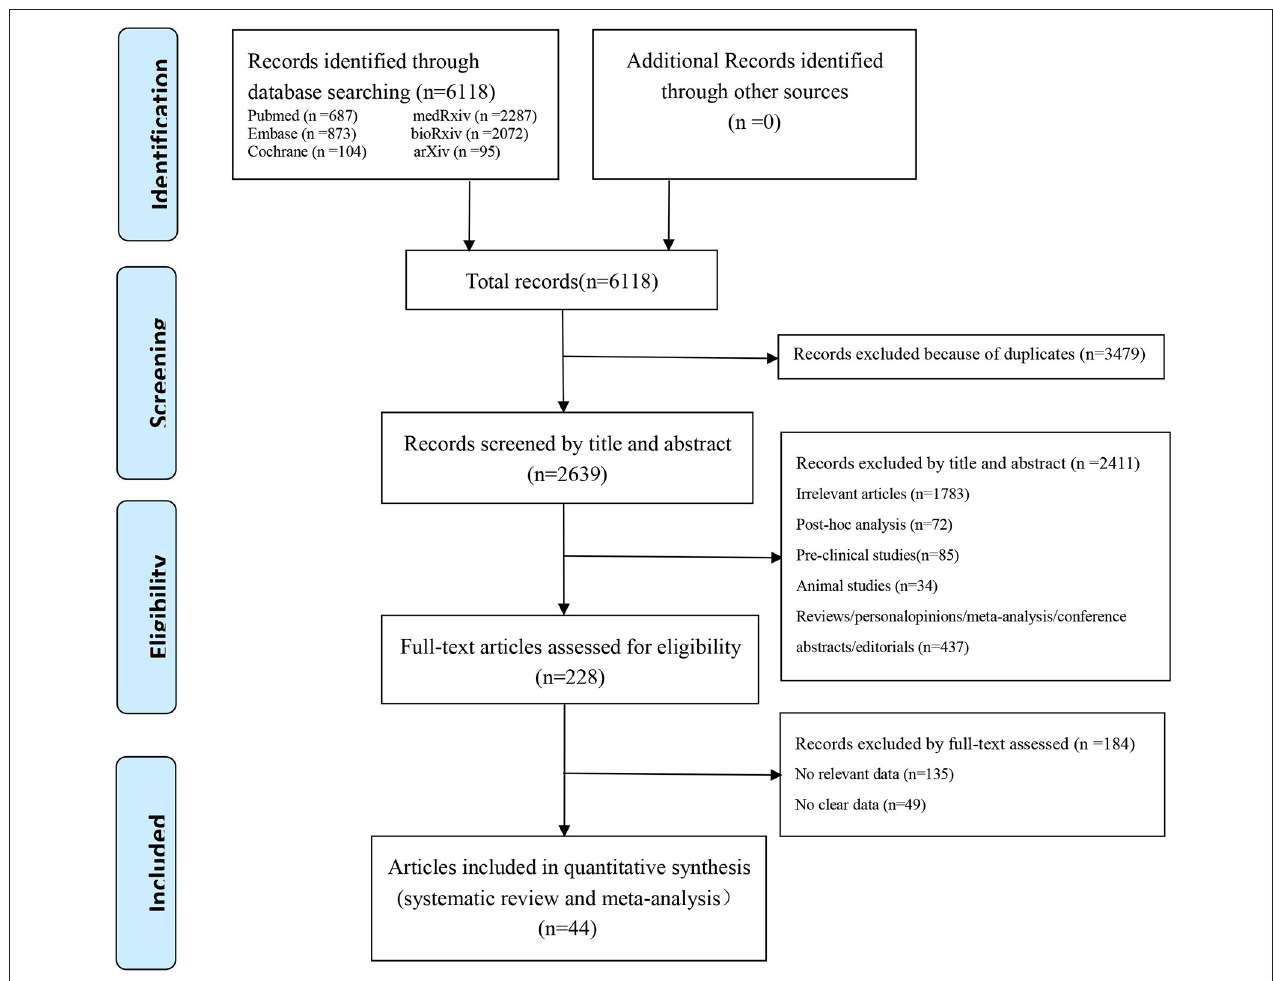
FIGURE 1 | PRISMA flow diagram of the study selection